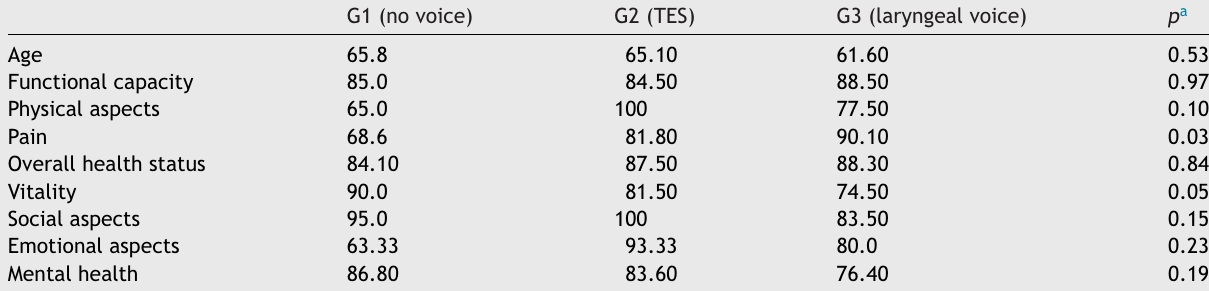
Comparison of the items of the SF-36 questionnaire according to study group.